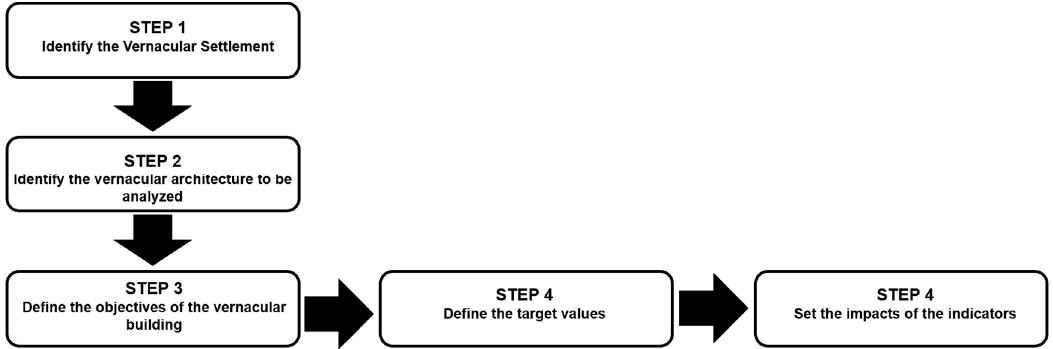
Figure 2. Sequence for identifying the objectives, target values and the impact of the indicators.